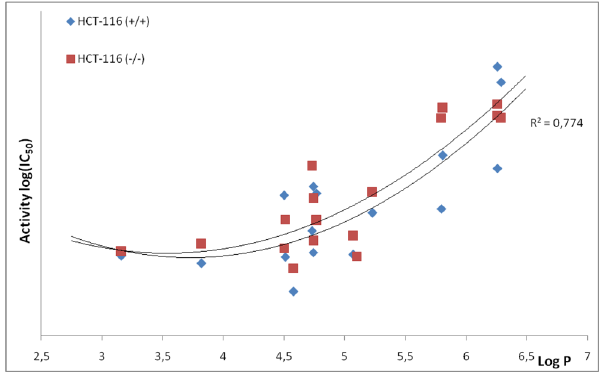
Fig 4. Activity (as — logIC 50 ) vs logP of the compounds that were tested.